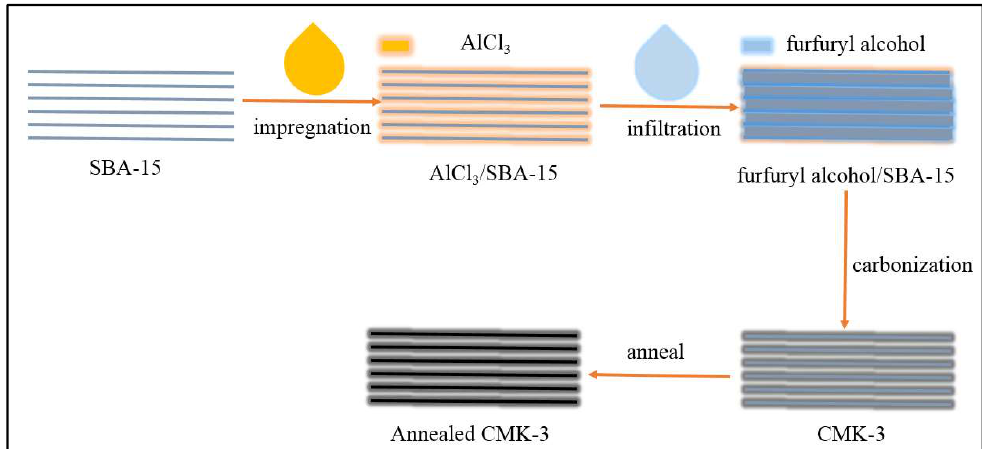
Figure 1. Preparation of annealed CMK-3.